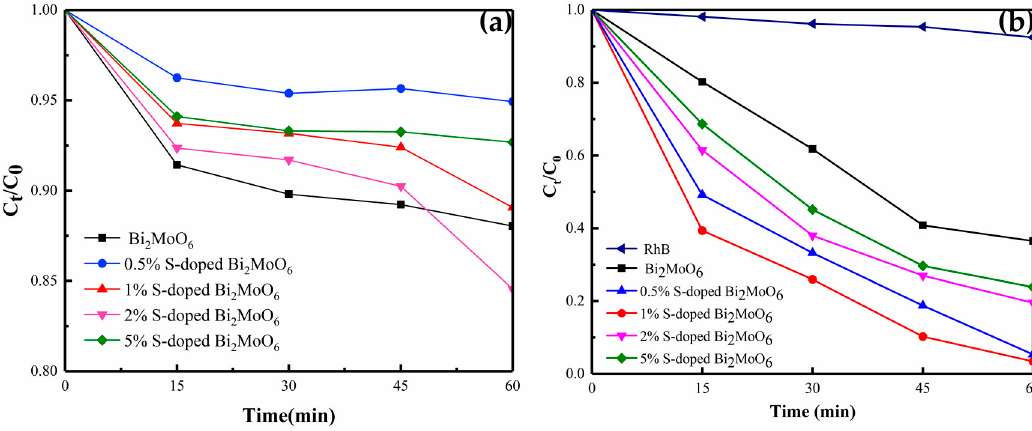
Figure 1. ( a ) The adsorption curves of pure Bi 2 MoO6 and Bi 2 MoO 6 with di ff erent S doping amounts in the dark, ( b ) the degradation rate of pure Bi 2 MoO 6 and Bi 2 MoO 6 with di ff erent S doping amounts under visible light